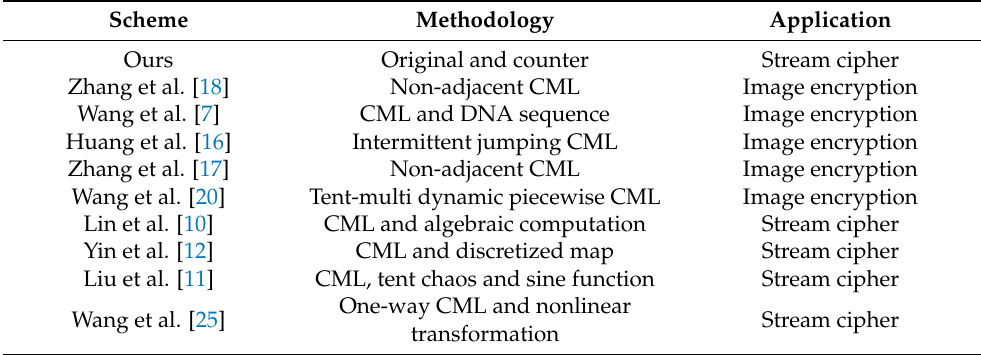
Table 5. The comparison between different CML methodologies and applications. Scheme Methodology Application Ours Original and counter Stream cipher Zhang et al. [18] Non-adjacent CML Image encryption Wang et al. [7] CML and DNA sequence Image encryption Huang et al. [16] Intermittent jumping CML Image encryption Zhang et al. [17] Non-adjacent CML Image encryption Tent-multi dynamic piecewise CML Image encryption Stream cipher Stream cipher Stream cipher One-way CML and nonlinear Stream transformation